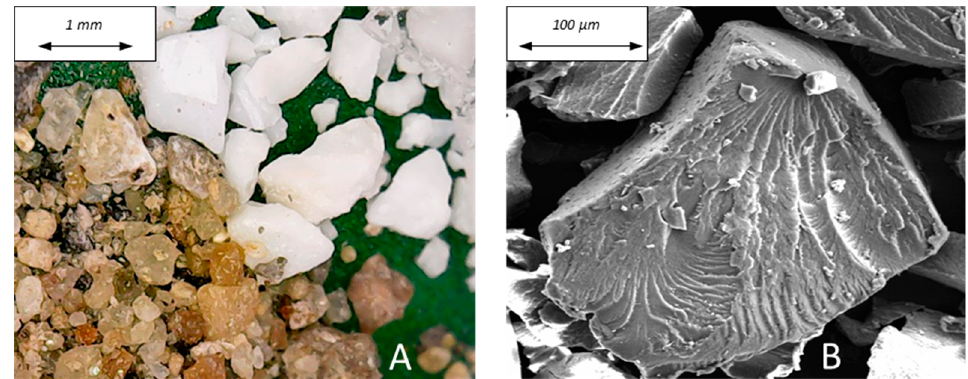
Figure 1. ( A ) Sand (left) and PET (right) grains and ( B ) SEM image of a PET grain.